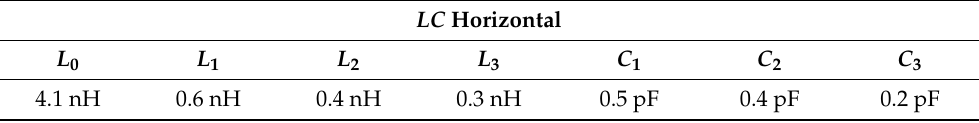
Figure 2. Design procedure of the proposed BLC. Table 1. LC components values for the LCEC of the proposed initial horizontal.